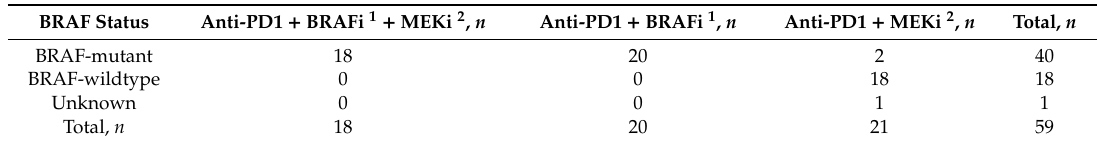
Table 2. Type of drug combination depending on the BRAF mutational status. BRAF Status Anti-PD1 + BRAFi 1 + MEKi 2 , n Anti-PD1 + BRAFi 1 , n